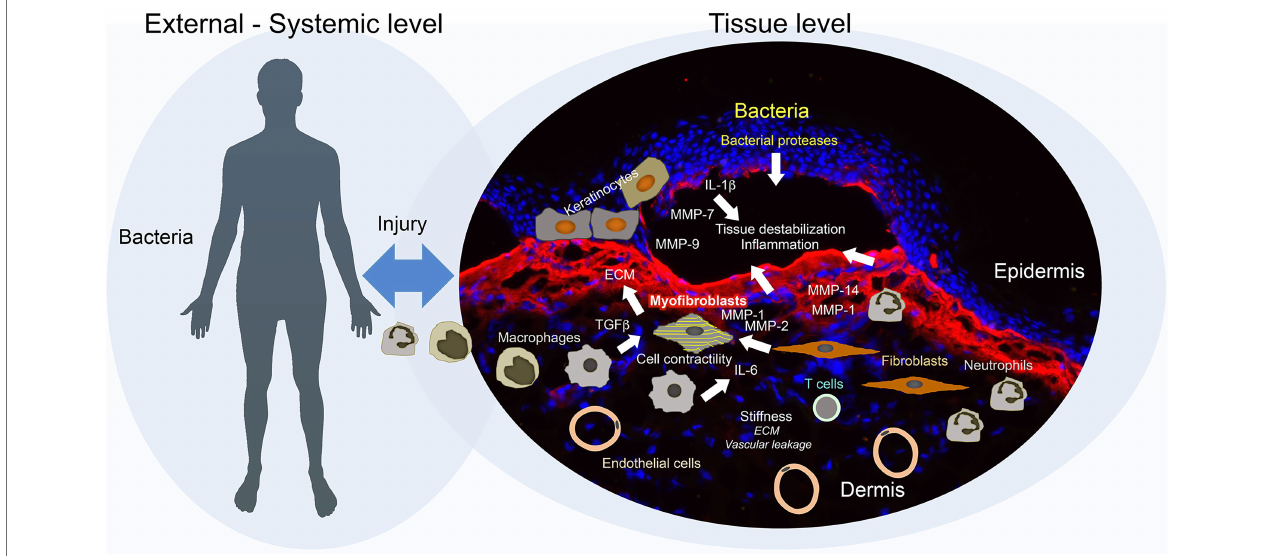
FIGURE 2 | Secondary disease mechanisms and potential disease modifiers in dystrophic epidermolysis bullosa (DEB). Disease progression in DEB is jointly driven by external and tissue-intrinsic factors. Frictional and mechanical challenges induce blistering of a pre-destabilized tissue, this together with high bacterial load trigger an exaggerated inflammatory and wound healing response. Bacteria may promote direct destruction of tissue through release of bacterial proteases. Epidermal keratinocytes, activated by impaired adhesion, injury, and inflammation, increase production of proteases, including matrix metalloproteinases (MMPs), which further evoke tissue degradation and inflammation. In addition, the keratinocytes secrete pro-inflammatory factors and trigger activation of dermal fibroblasts. Inflammatory cells – inflammatory macrophages and neutrophils – promote tissue degradation through secretion of MMPs and elastase, and activation of fibroblasts through release of, e.g., TGFß and IL-6. Activated fibroblasts respond by increasing production of provisional and interstitial extracellular matrix (ECM) and altering the ECM architecture to a stiffer structure. Vascular leakage enhanced by the hyper-vascularized tissue may cause a transient increase in stiffness triggering stiffness response in fibroblasts. Increasing stiffness and TGF β , which is released by multiple cell types – keratinocytes, fibroblasts, inflammatory cells, and platelets – and activated by several mechanisms – integrins, proteases, thrombospondin-1, and ROS – promote conversion of fibroblasts to contractile myofibroblasts. With time, adaptive immune activation occurs which may further enhance chronic inflammation and injury response. Collectively, these multifaceted mechanisms promote the establishment of a fragile, fibrotic, and contractile tissue that supports the growth of squamous cell